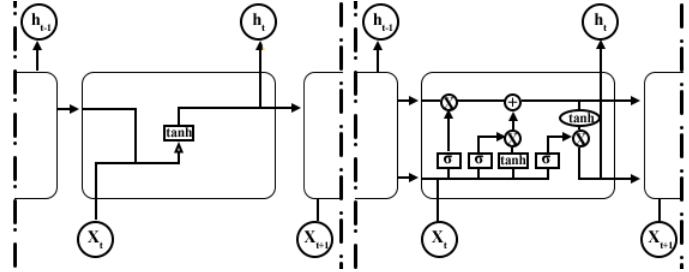
Figure 5. Difference between FNN ( left ) and LSTM Neurons ( right ).